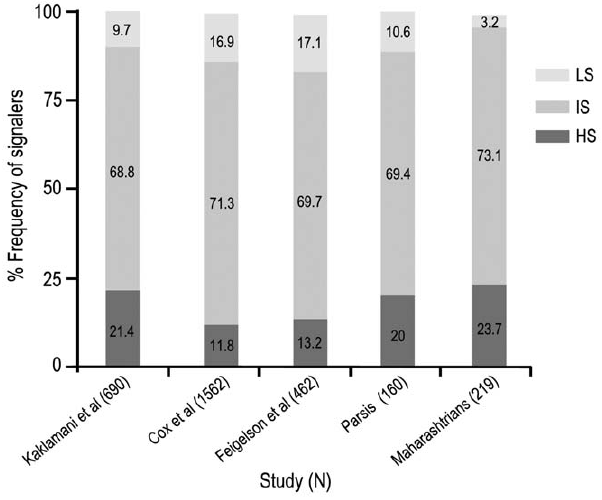
Figure 1. Comparison of frequencies of High, Intermediate and Low signalers in various studies reported so far. Numbers in parentheses represent the number of healthy subjects studied in each